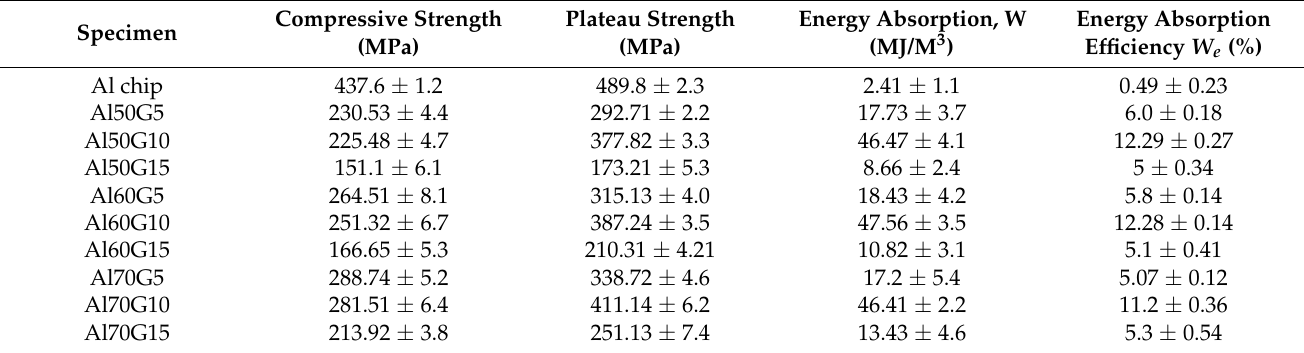
Figure 12. Predicted (do tt ed lines) and measured (dots) compressive strengths of AlG foam with di ff erent GHS contents.